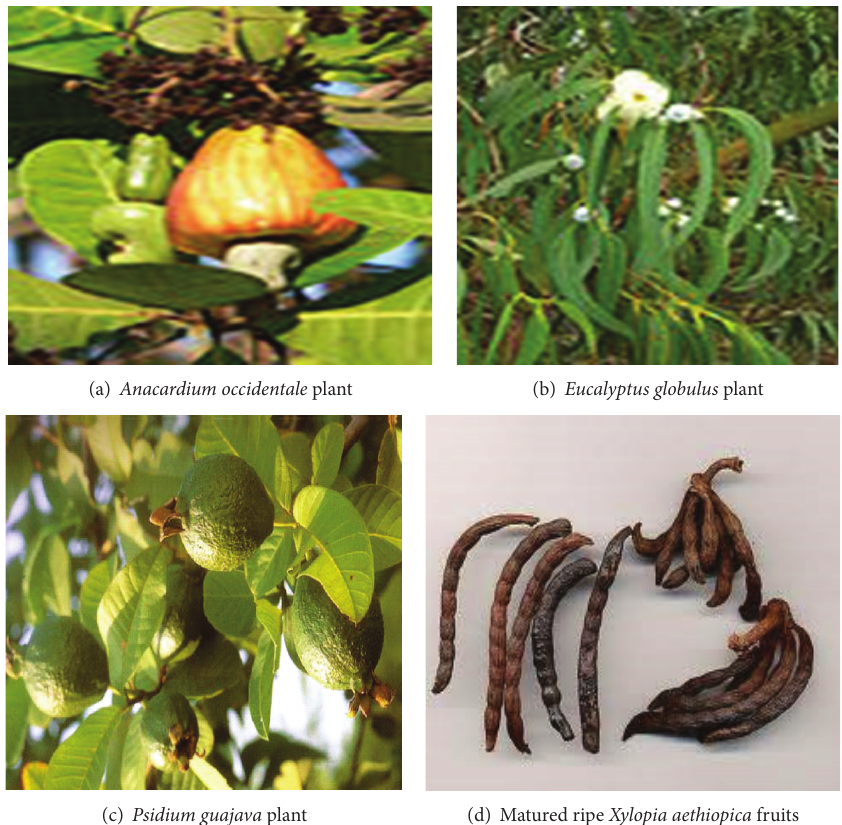
Figure 1: Medicinal plants used as combine therapy for this